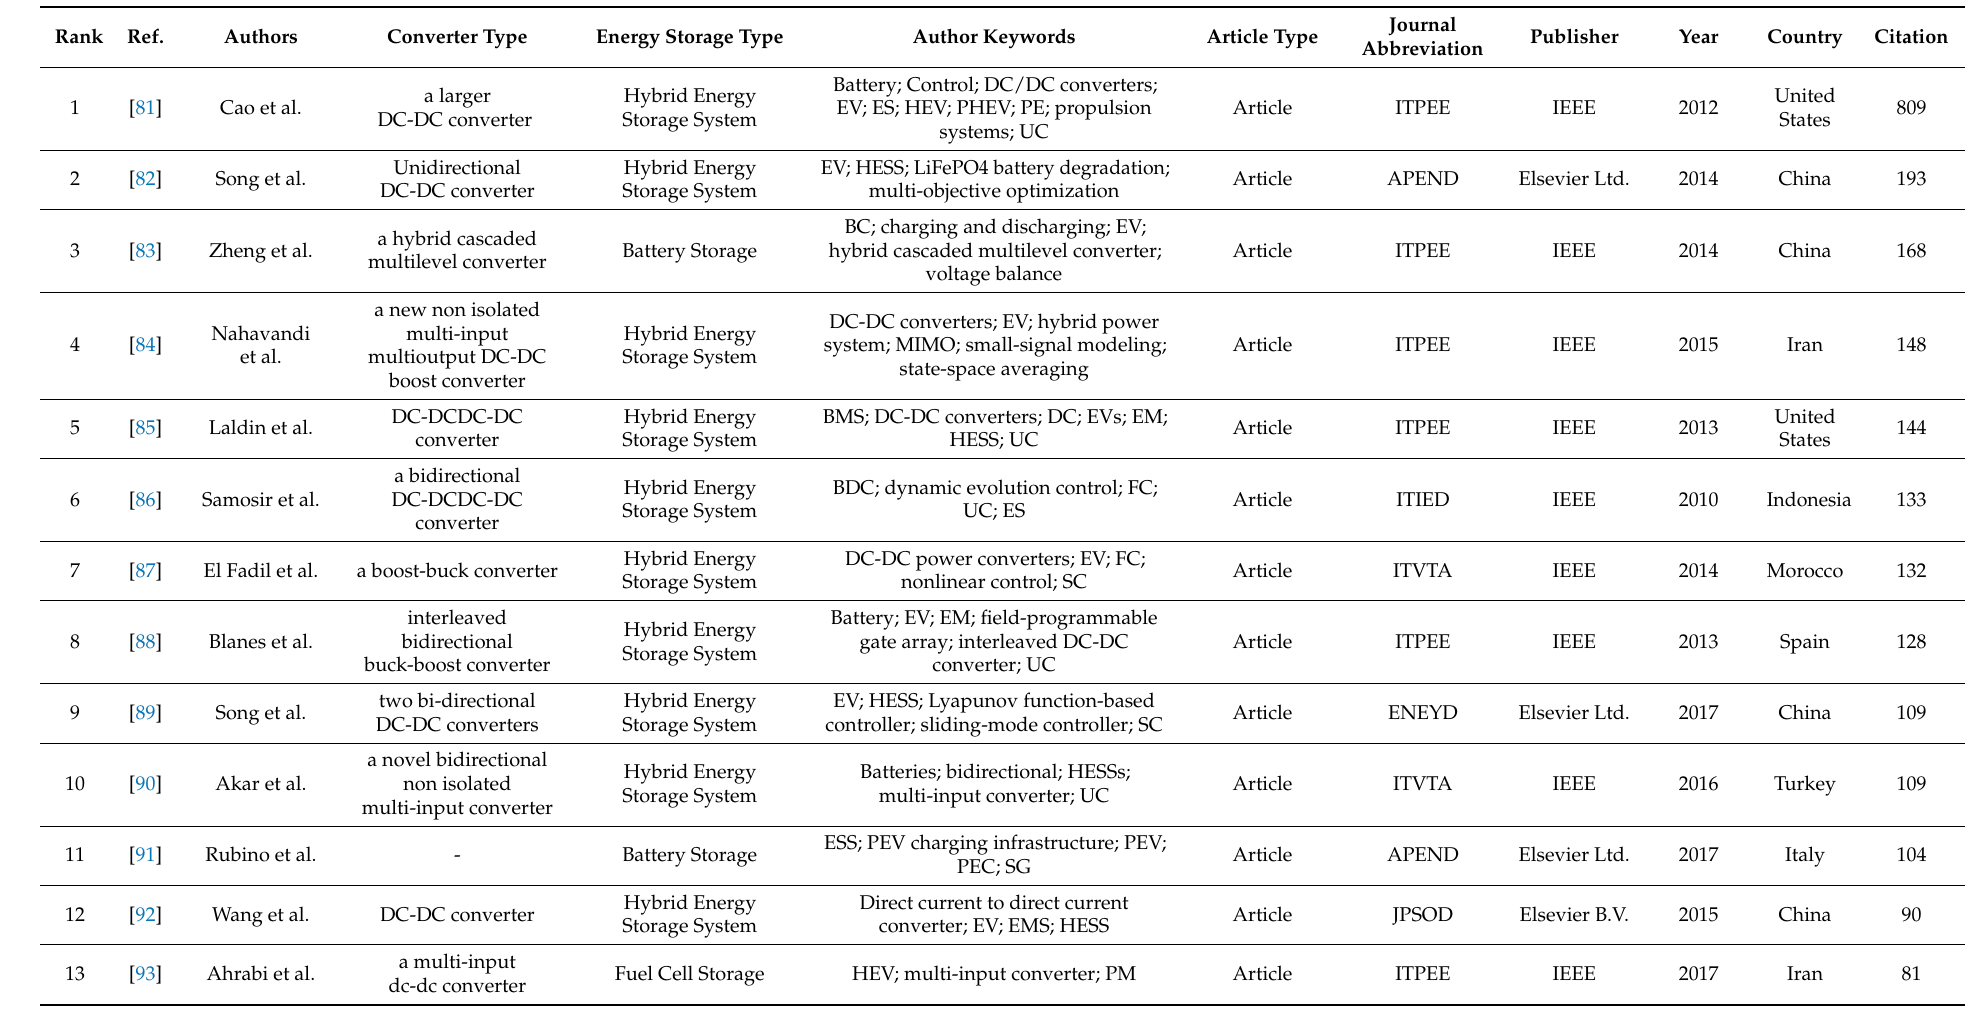
Table 3. The most relevant 100 articles in the field of PEC integrated ESM in EV applications. Rank